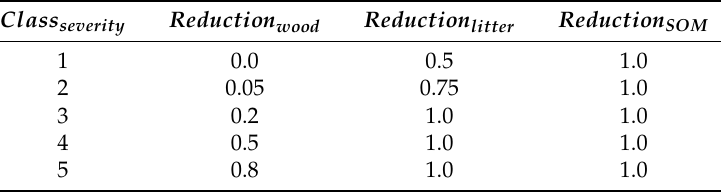
Table A28. Fire reduction parameters; inactive.